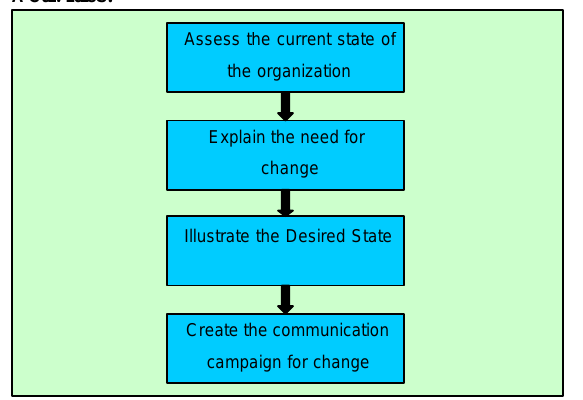
Figure 1: Activities Performed in Phase 1 Phase 2: Build the Re -engineering Organization